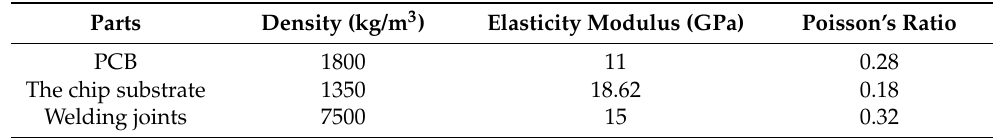
Table 1. Material parameters of the CPU board